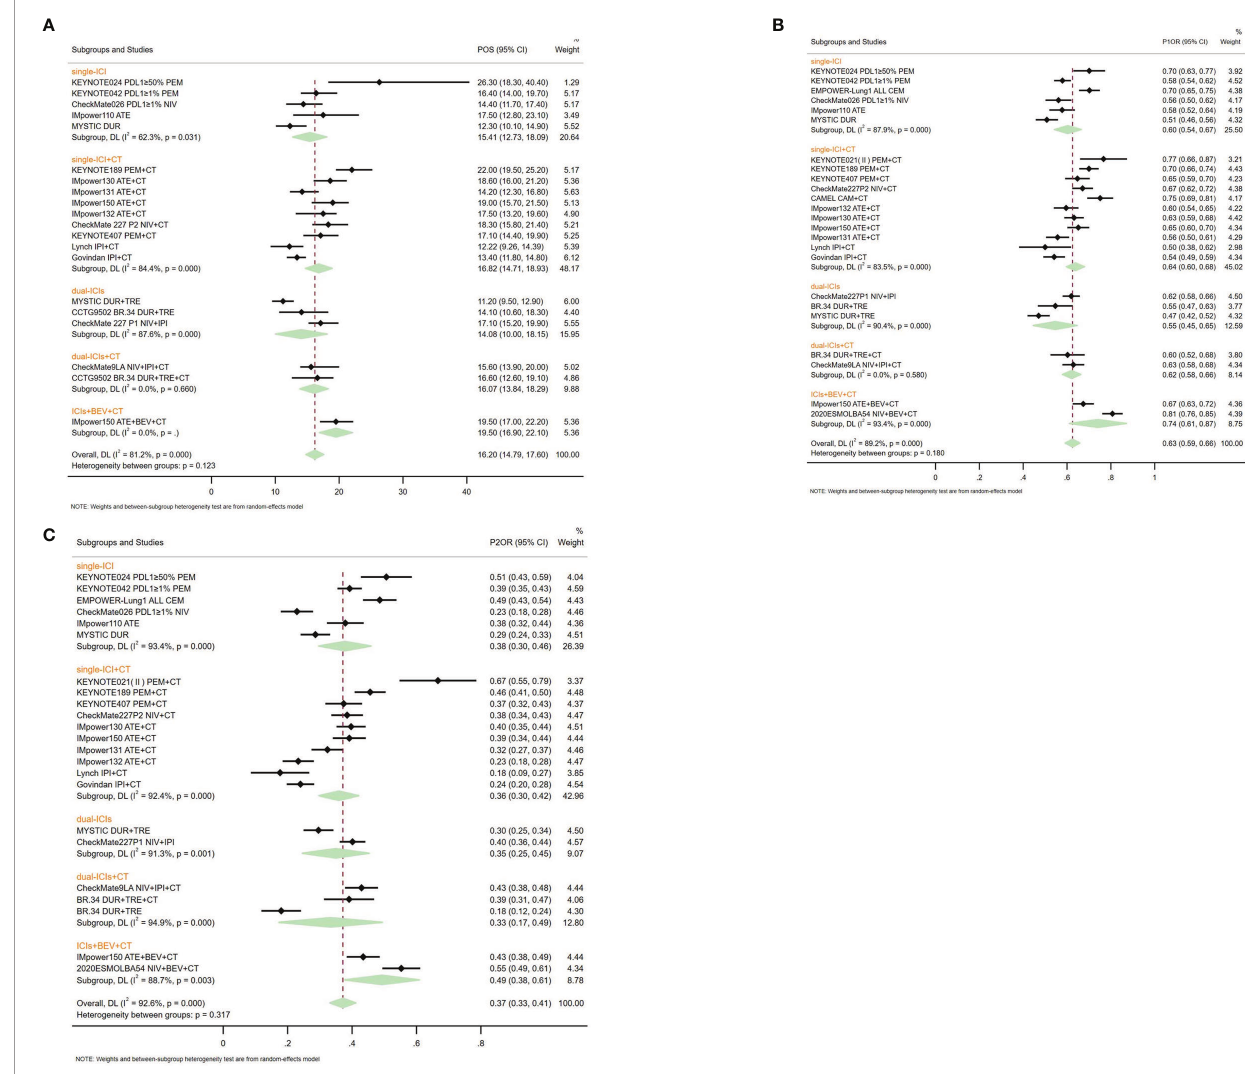
FIGURE 2 | Pooled survival outcomes from integrated analysis of median overall survival (A) , 1-year survival rate (B) , and 2-year survival rate (C) of different therapy strategies containing immune checkpoint inhibitors in patients with advanced wild-type non-small cell lung